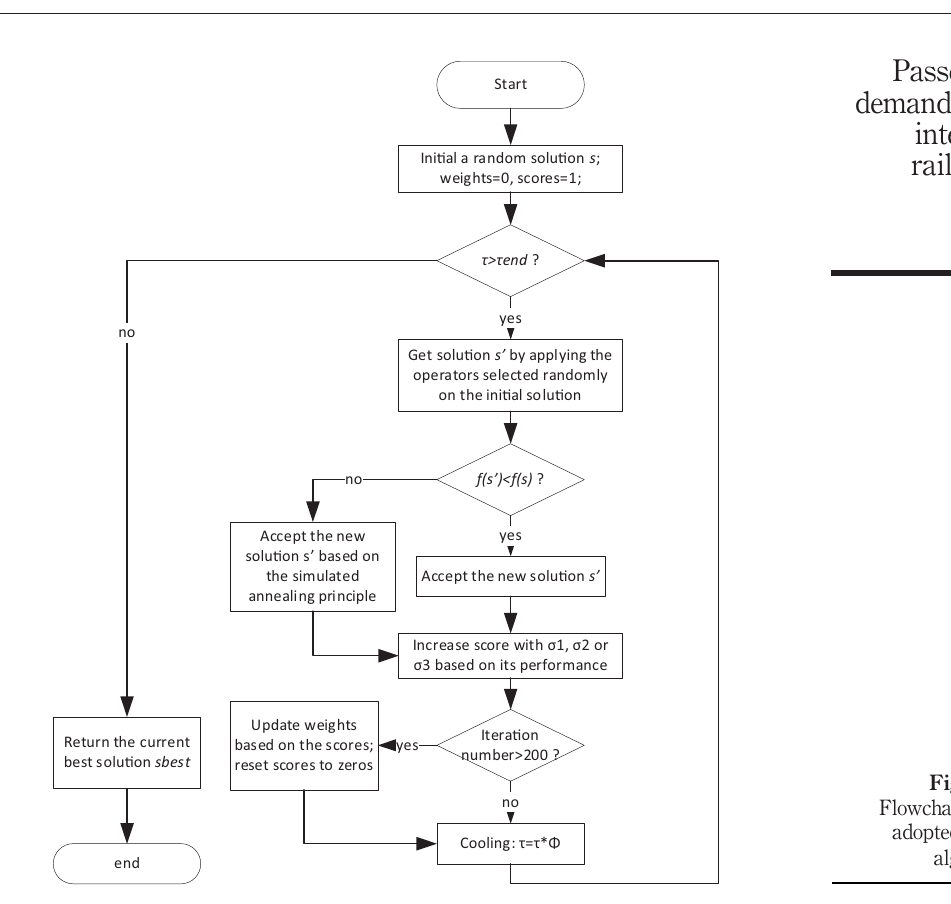
Figure 3. Flowchart of